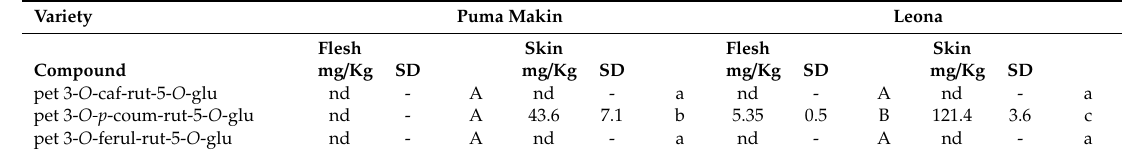
Table 4. Anthocyanins in the flesh and skin of the different tubers expressed as mg/Kg DW. Data are expressed as mean ± standard deviation. Different letters indicate significant differences among varieties for each compound ( p < 0.05) for the flesh tissue (uppercase letters) and for the skin tissue (lowercase letters).